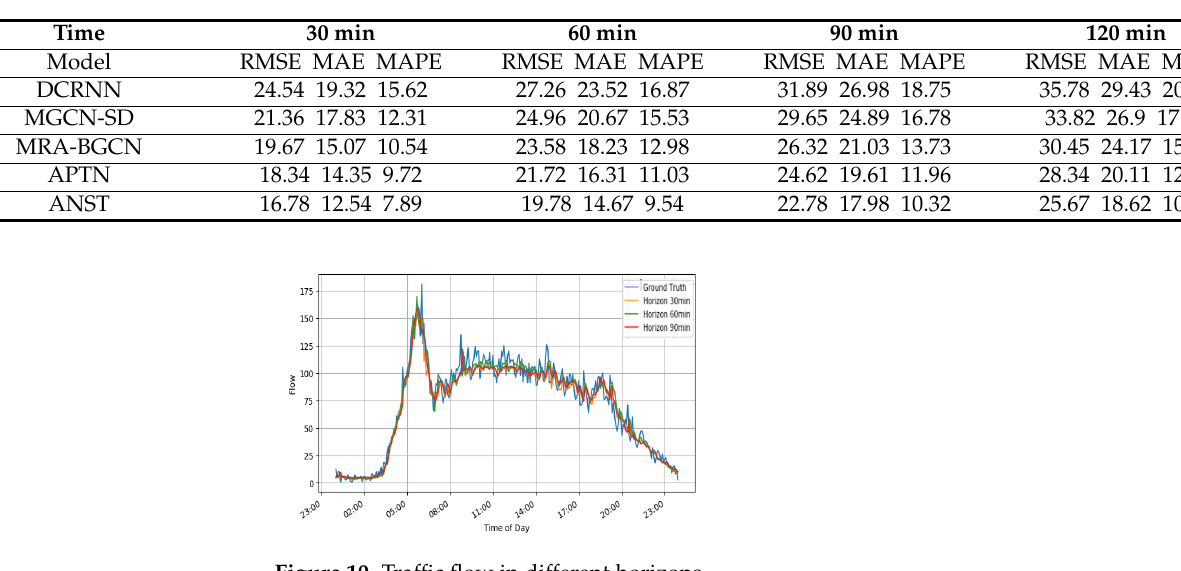
Table 2. Comparison of different models.